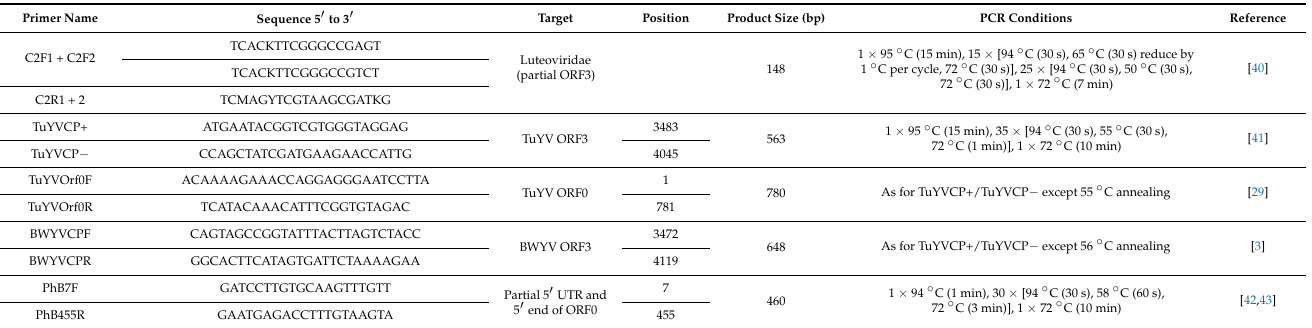
Table 2. Primer sequences, genomic target, primer position, expected PCR product size and cycle conditions used in this